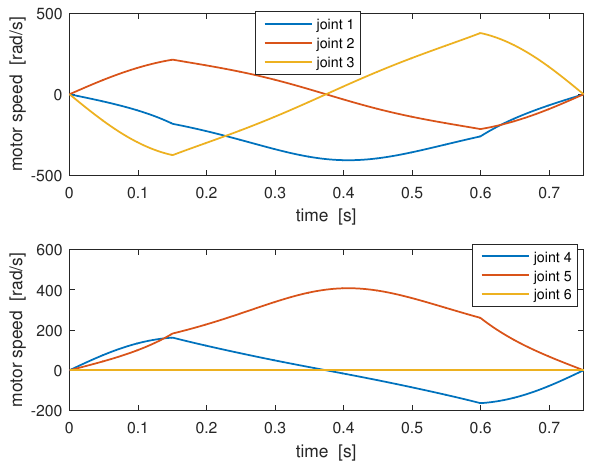
Figure 2. Motor speed for nominal tool orientation with the non-optimized profile: ϕ = 0 rad , θ = 0 rad , ψ = 3 π /2 rad .